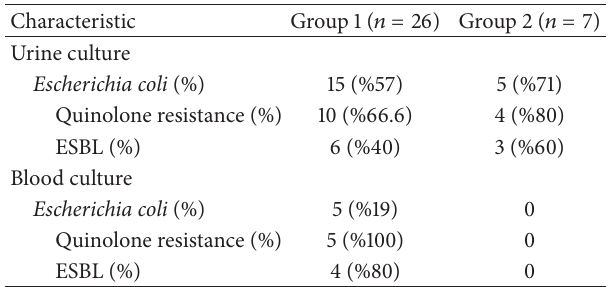
Table 3: Distribution of bacteria in urine and blood culture accord- ing to